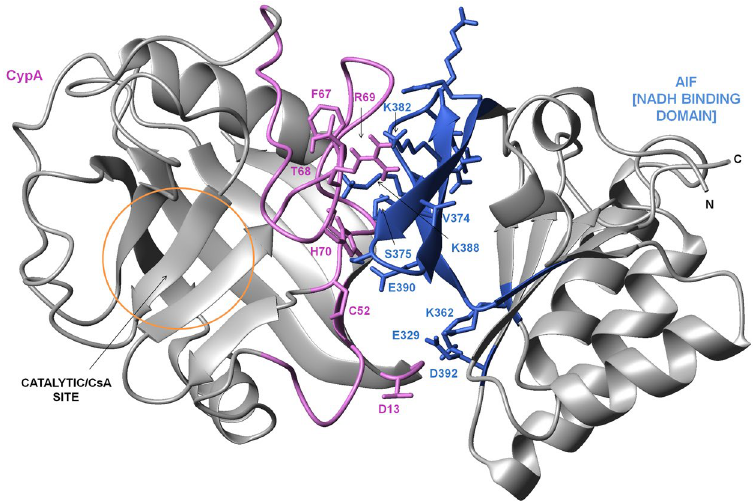
Figure 6. Molecular docking studies. Model of CypA/AIF( Δ 1-121) complex provided with the lowest/best Haddock score. The binding regions and side chains of binding residues of CypA and AIF are indicated in violet and royal blue,